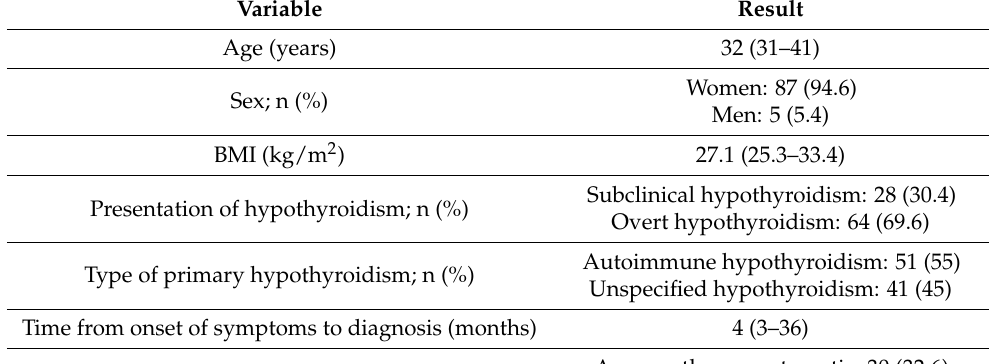
Table 1. Baseline characteristics of the participants in the study (n = 92). Variable